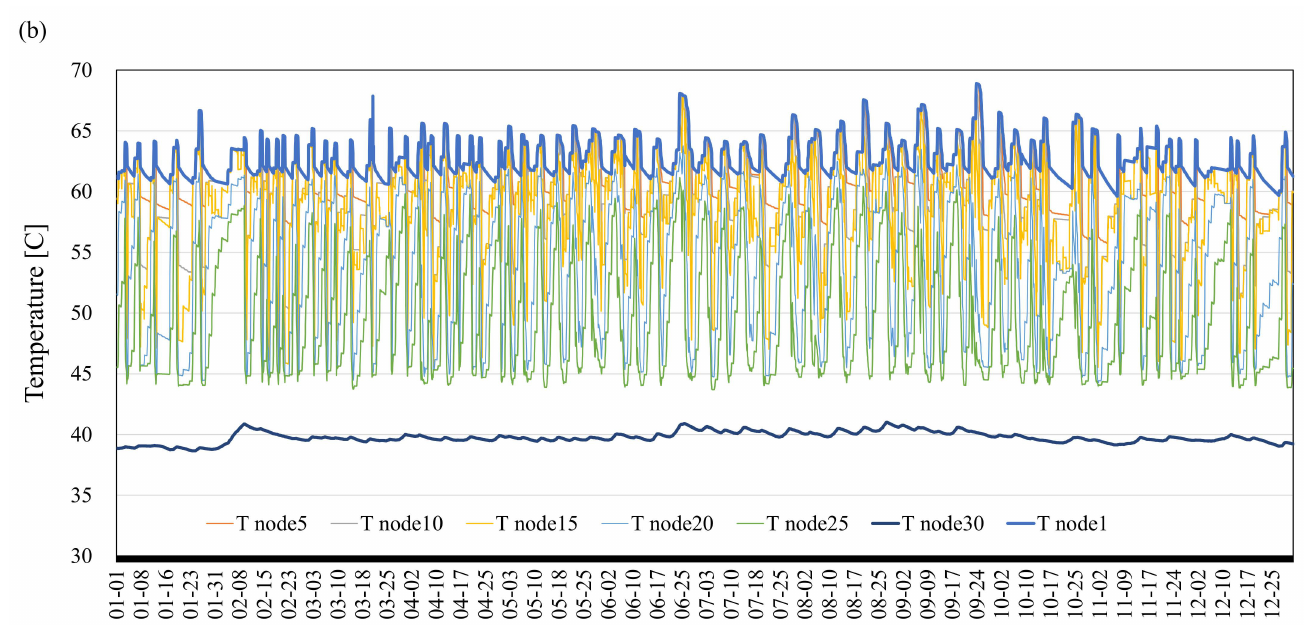
Figure 11. Operating profile of TES: ( a ) monthly operation of TES, ( b ) hourly inner operating temperature of